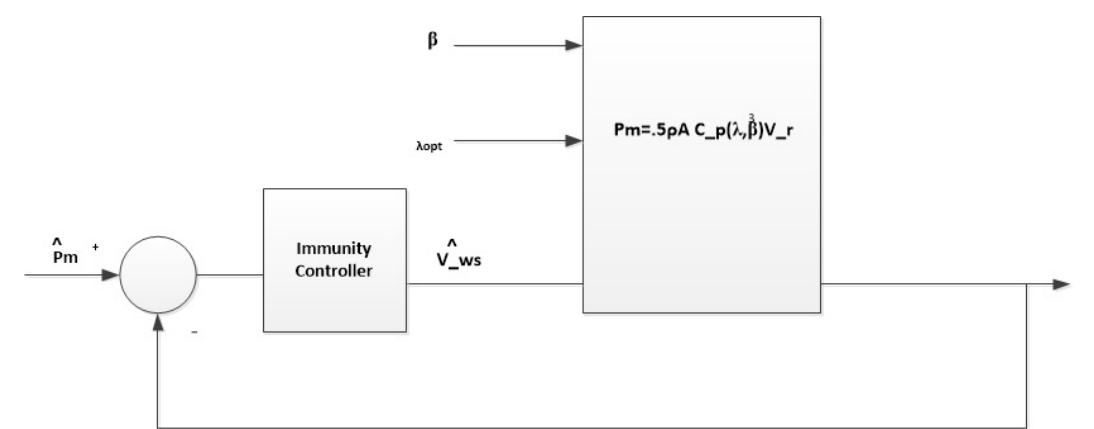
Figure 2. An artificial immunity technique based wind speed estimation.